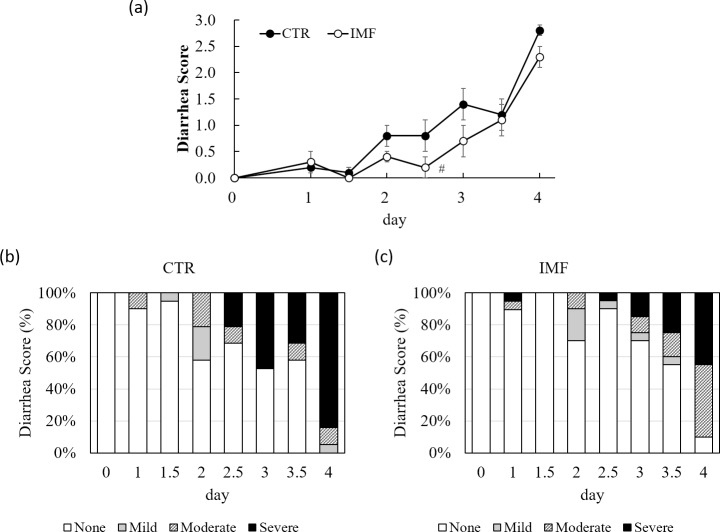
Average diarrhoea score and incidence of diarrhoea over time in the CTR and IMF rats.(a) average diarrhoea score, (b) incidence of diarrhoea in the CTR rats after 5-FU injection and (c) incidence of diarrhoea in the IMF rats after 5-FU injection. Values are means ± standard error. # P < 0.1, vs. CTR group.